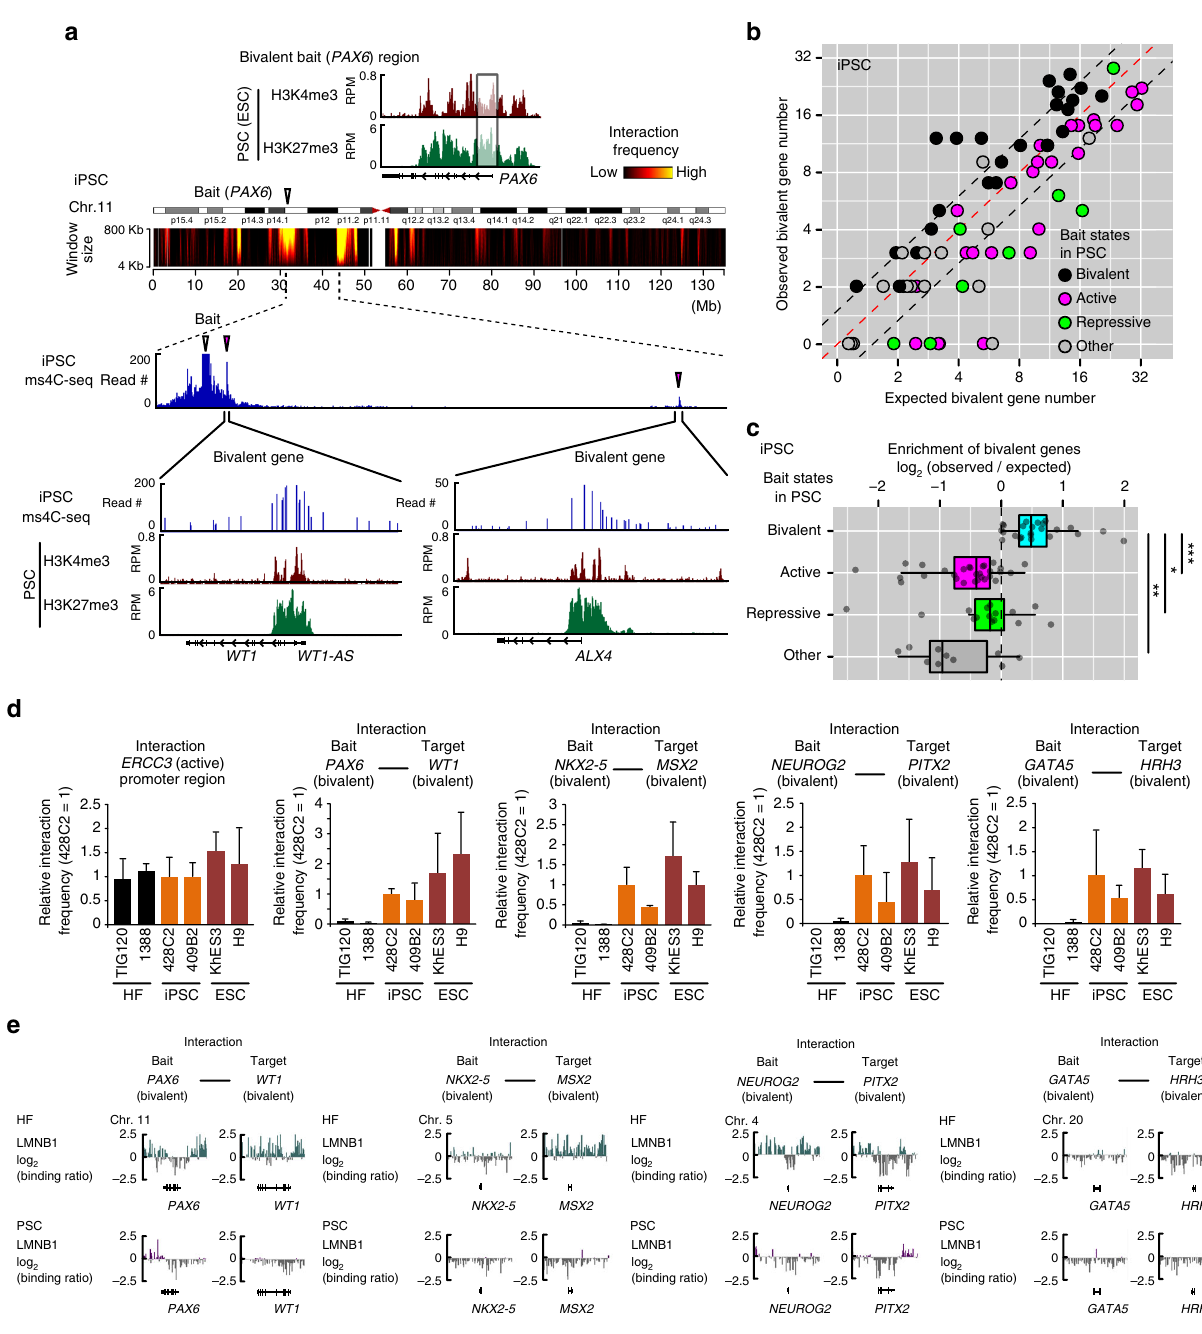
Fig. 5 Bivalent gene loci colocalize in hPSCs. a The distribution of histone modi fi cations for H3K4me3 and H3K27me3 in the PAX6 bait locus and their target loci. ChIP-seq data are represented by RPM signals for H3K4me3 and H3K27me3 in ESCs below ms4C-seq interaction signals in iPSCs. b Bivalent gene numbers in the interaction target genes of active, repressive, and bivalent bait loci in iPSCs (428C2). The scatter plot shows the expected numbers of bivalent gene ( x -axis) and observed numbers of bivalent genes ( y -axis) in the interaction targets of each bait locus. The expected number was calculated by the proportion of bivalent genes present on the same chromosome as bait loci. Bait genes were divided into bivalent (black), active (magenta), repressive (green), and other (gray) in PSCs (ESCs) according to Fig. 1b. c The enrichment of bivalent genes in interaction target genes of bivalent bait loci in iPSCs (428C2). Box plots show log 2 (observed frequency for bivalent genes)/(expected frequency for bivalent genes) in interaction targets of bivalent, active, repressive, and other bait gene loci ( U -test, * p < 3 × 10 − 5 , ** p < 1 × 10 − 5 , and *** p < 1 × 10 − 11 ). d Interaction frequencies of bivalent gene loci in hESCs (KhES3 and H9), hiPSCs (428C2 and 409B2), and their original HFs (TIG120 and 1388). Bar graphs indicate the interaction frequencies of the indicated gene loci determined by enhanced 3C-qPCR analysis. The interaction frequencies in the ERCC3 promoter region are shown as positive interaction controls. Data are shown as means ± SD from three biological replicates. e Lamina-association pro fi les of colocalized bivalent gene loci are indicated by log 2 (Dam- LMNB1/Dam) in HFs and PSCs (ESCs) 40, 41 . See also Supplementary Figs. 4 –